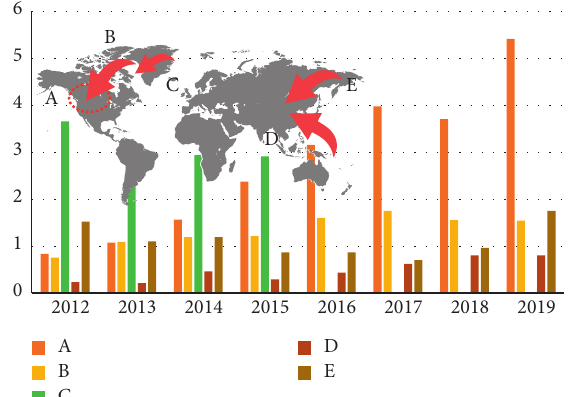
Figure 7: Comparison of the relationship between the city index and statistical